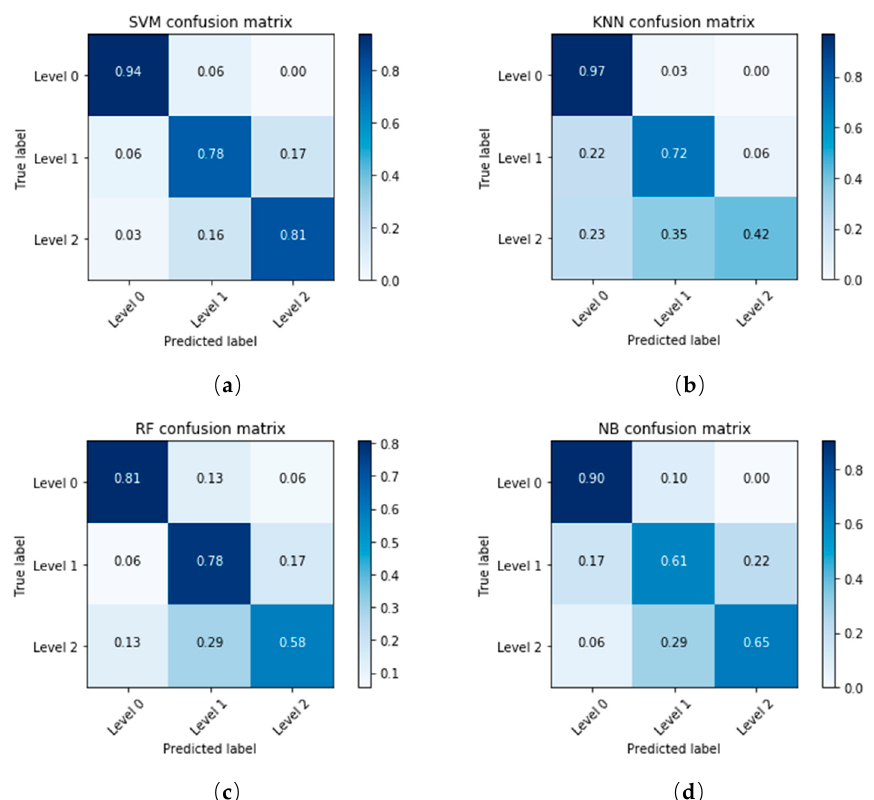
Figure 8. The confusion matrices of SVM, KNN, RF and NB models using the thermal dataset.